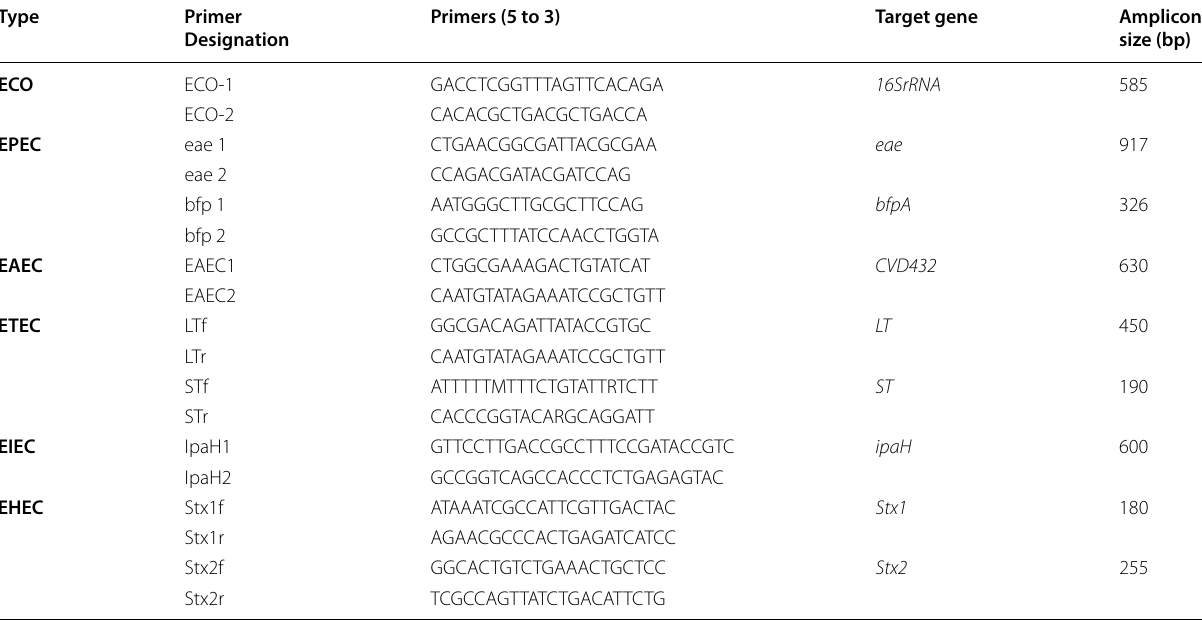
EIEC Enteroinvasive E. coli, EHEC Enterohemorrhagic E. coli, EAEC Enteroaggregative E. coli, EPEC Enteropathogenic E. coli, ETEC Enterotoxigenic E. coli